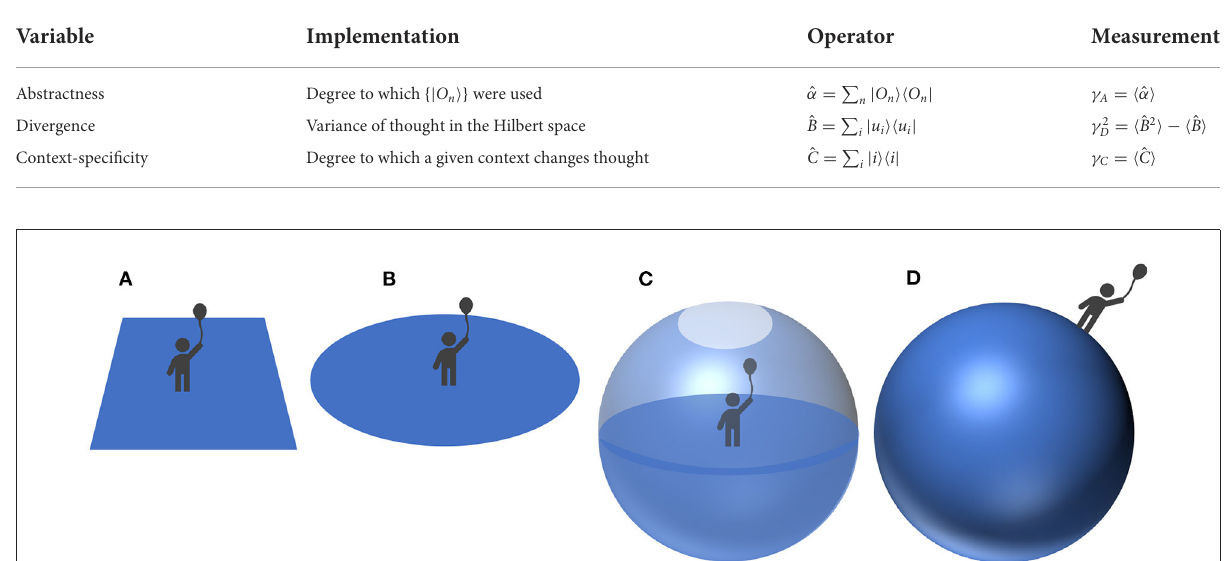
FIGURE2 Visual depiction of the mental models of the Earth (A) Flat Earth. (B) Disc Earth: the child understands that Earth is round, but does not yet understand that the Earth is spherical. (C) Hollow Earth: the child understands that the Earth is spherical, and invents a conception of the Earth that incorrectly reconciles this with the personal experience of it being flat. (D) Spherical Earth: the child’s conception of the shape of the Earth matches that of an adult. Some children had a Flattened Spherical Earth model (not shown), similar to the Spherical Earth model but with flatter top and bottom surfaces (i.e., more oblong in shape). Dual Earth combines mental representations of the Flat Earth or Disc Earth with concepts of the spherical Earth, but maintains two separate representations. From Gabora et al. (2022).